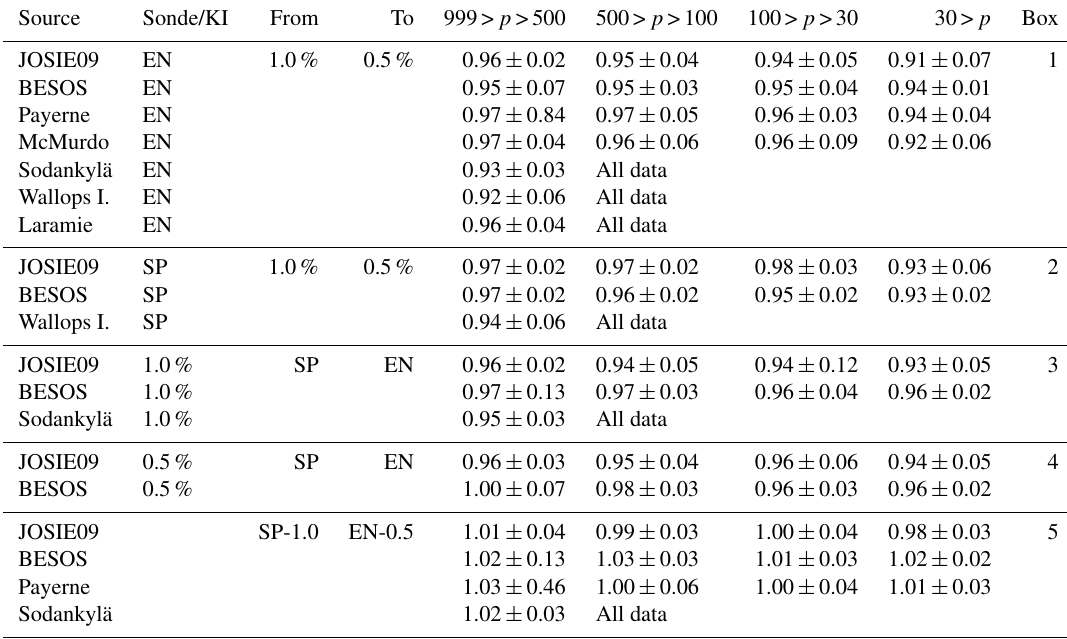
Table 2. Mean and standard deviations of the various comparison measurements. The mean ratio is equivalent to the slope of a linear fit to the data which passes through the origin. For the data sets with the most data and the most varied comparisons the means and standard deviations are given for the pressure intervals indicated at the top. For the other data sets the means and standard deviations are given for all the data without regard to pressure.